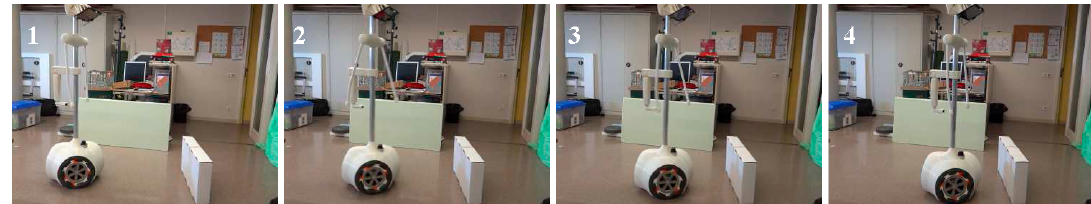
Figure 11. Sequence of images ( 1 – 4 ) obtained in a collision avoidance experiment with the APR moving forward.